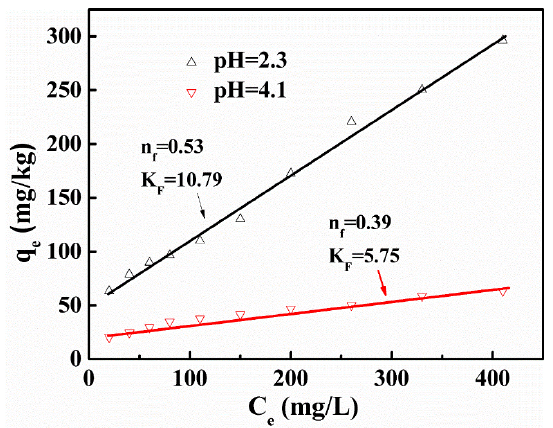
Figure 4. The Freundlich model fittings of SPA adsorption on the rutile